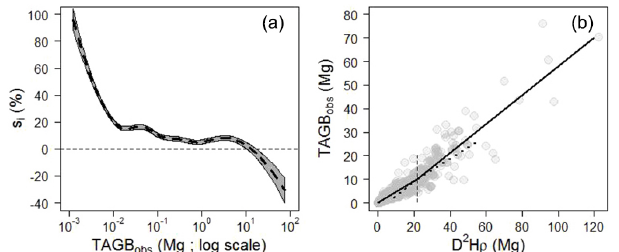
Figure 3. Panel (a) : relative individual residuals ( s i in %) of the ref- erence biomass allometric pantropical model of Chave et al. (2014) against the tree AGB gradient. The thick dashed line represents the fit of a local regression (loess function, span = 0.5) bounded by standard errors. Panel (b) : observed tree AGB (TAGB obs ) vs. the compound variable D 2 × H × ρ , with D and H being the tree stem diameter and height, respectively, and ρ the wood density. A segmented regression revealed a significant break point (thin verti- cal dashed line) at approximately 10Mg of TAGB obs (Davies test p value<2.2 × 10 − 16